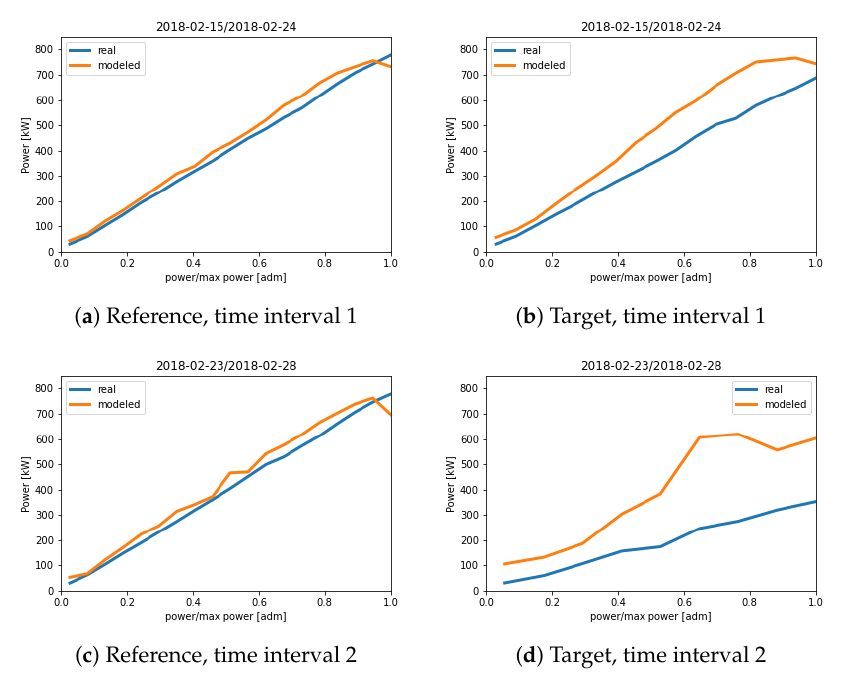
Figure 4. Measured and simulated power for the reference (Ref) and the target (Tar) wind turbines, for several examples of time windows approaching the fault ( D fault ).